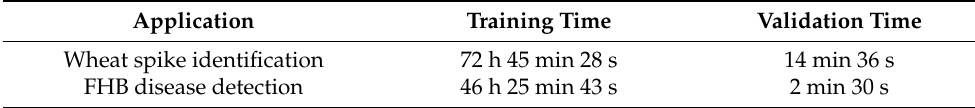
Table 3. The total time for model training and